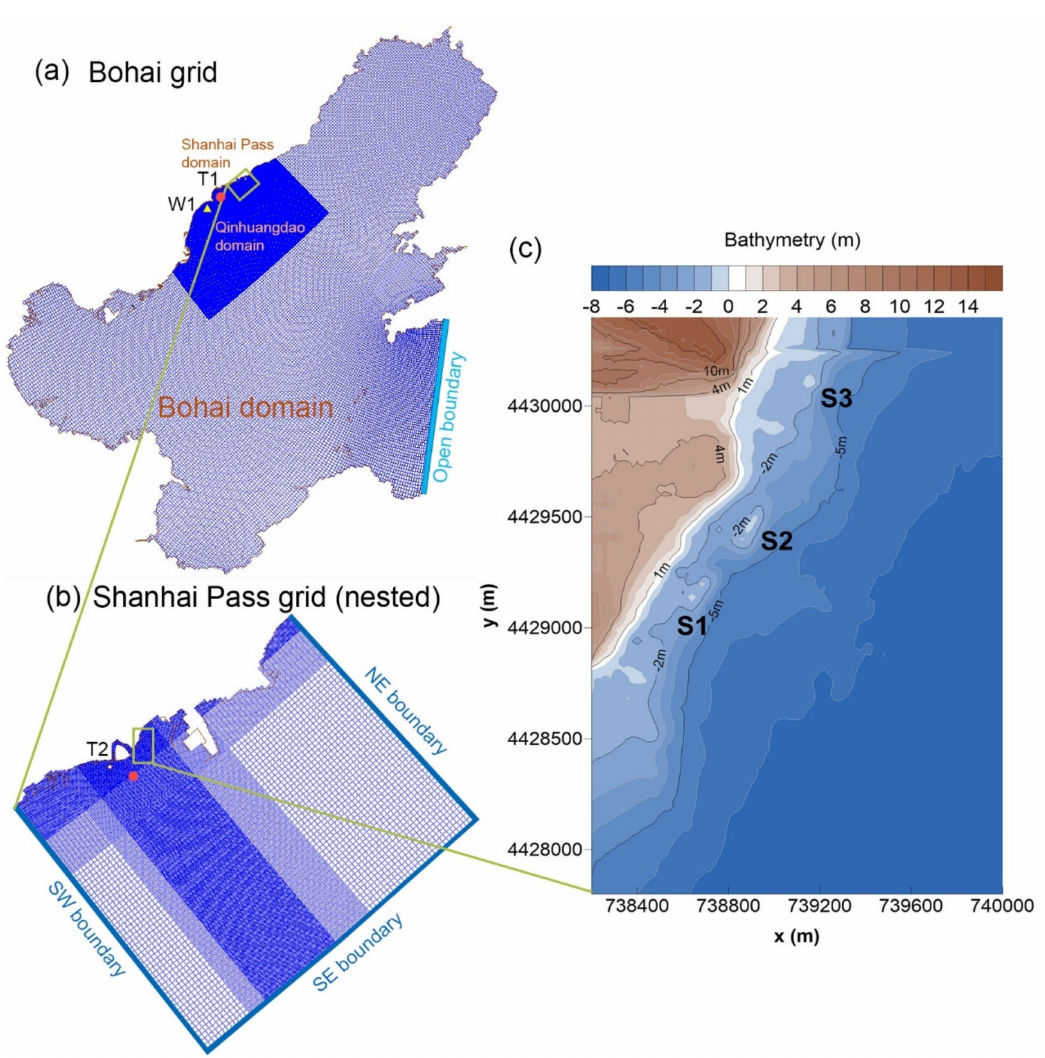
Figure 2. ( a ) Regional grid for the Bohai model with Qinhuangdao domain refined locally, ( b ) spatially varying nested grid for Shanhai Pass local model and ( c ) the bathymetry of Shanhai Pass beach just after the completion of the nourishment project; T1 and T2 represent the Qinhuangdao and Shanhai Pass tidal stations, respectively, and W1 represents the wave station at